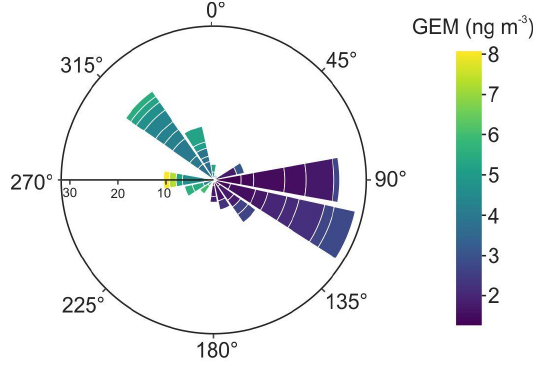
Figure 5. Wind rose for GEM data at Trieste (time-series: TS2_3). Colours indicate GEM concentration, while the radius length is the cumulative wind speed (m s –1 ).